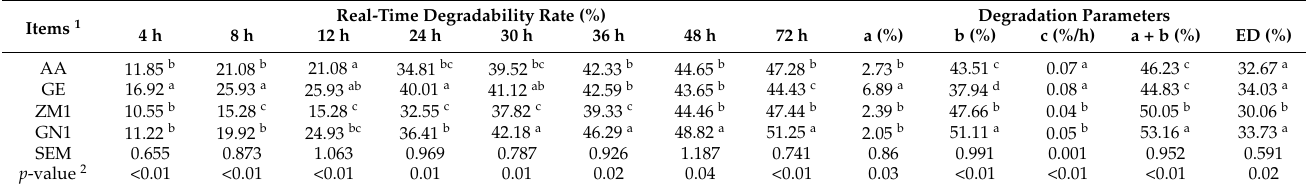
Table 6. Rumen degradable characteristics of NDF from various alfalfa hay cultivars %.